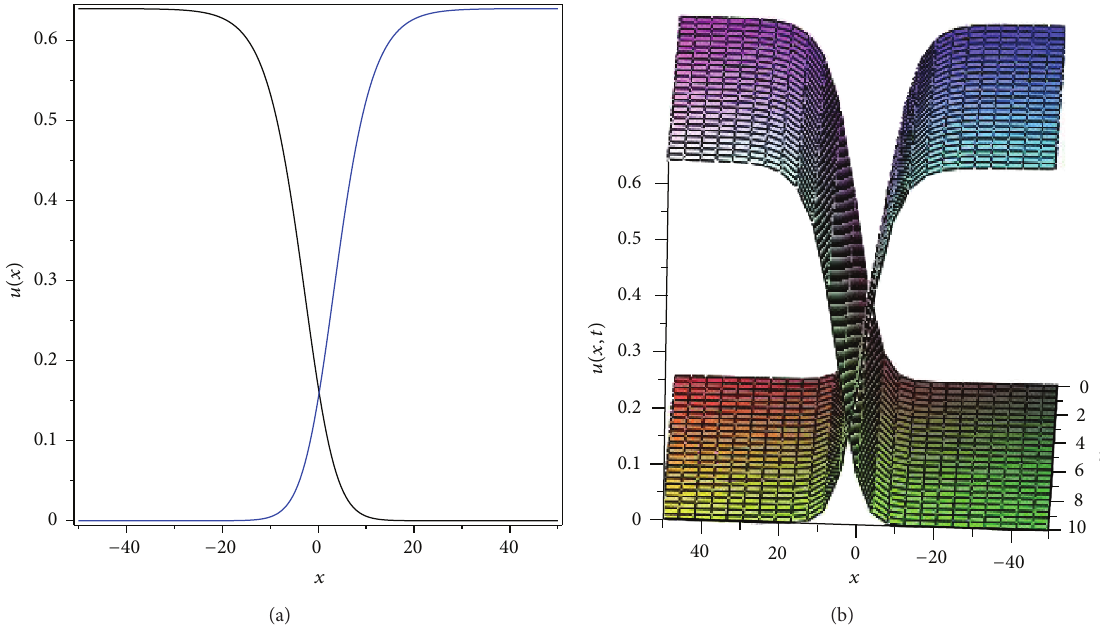
Figure 1: (a) 2D profile of (35): kink shaped solitary ( 𝑢 +, blue line), anti-kink shaped solitary ( 𝑢− , black line). (b) Corresponding 3D plots when + sign is taken and when − ve sign is taken, with 𝛼 = 1 , 𝛽 = −1 , and 𝛿 = 1